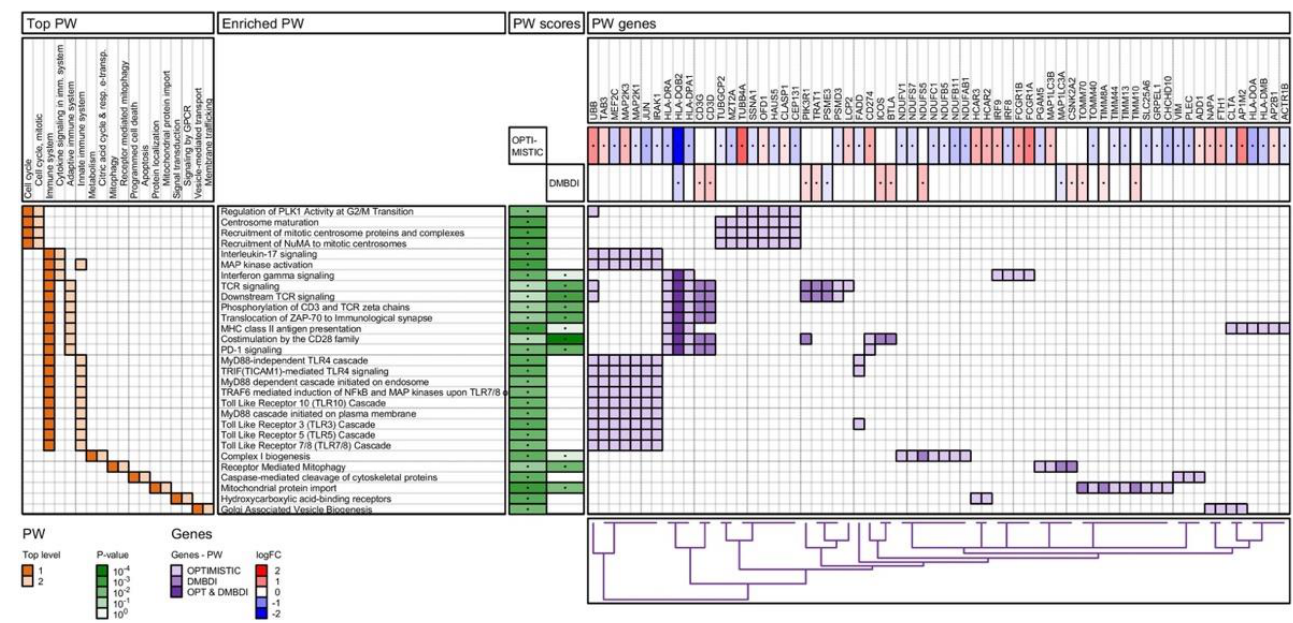
Figure 5. Reactome pathway (PW) enrichment analysis of OPTIMISTIC and DMBDI genes. For explanation see Section 2.4.